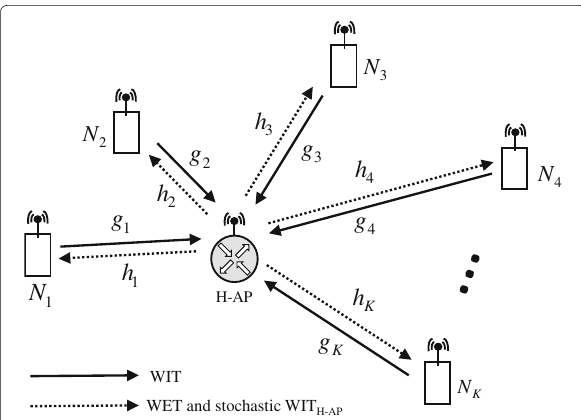
Fig. 1 System model: Large-scale WPCN. The proposed system model, large-scale WPCN, is illustrated, which consists of one H-AP and multiple nodes. N denotes the number of nodes. In addition, h i and g i denote the channel power gain of the DL and UL,